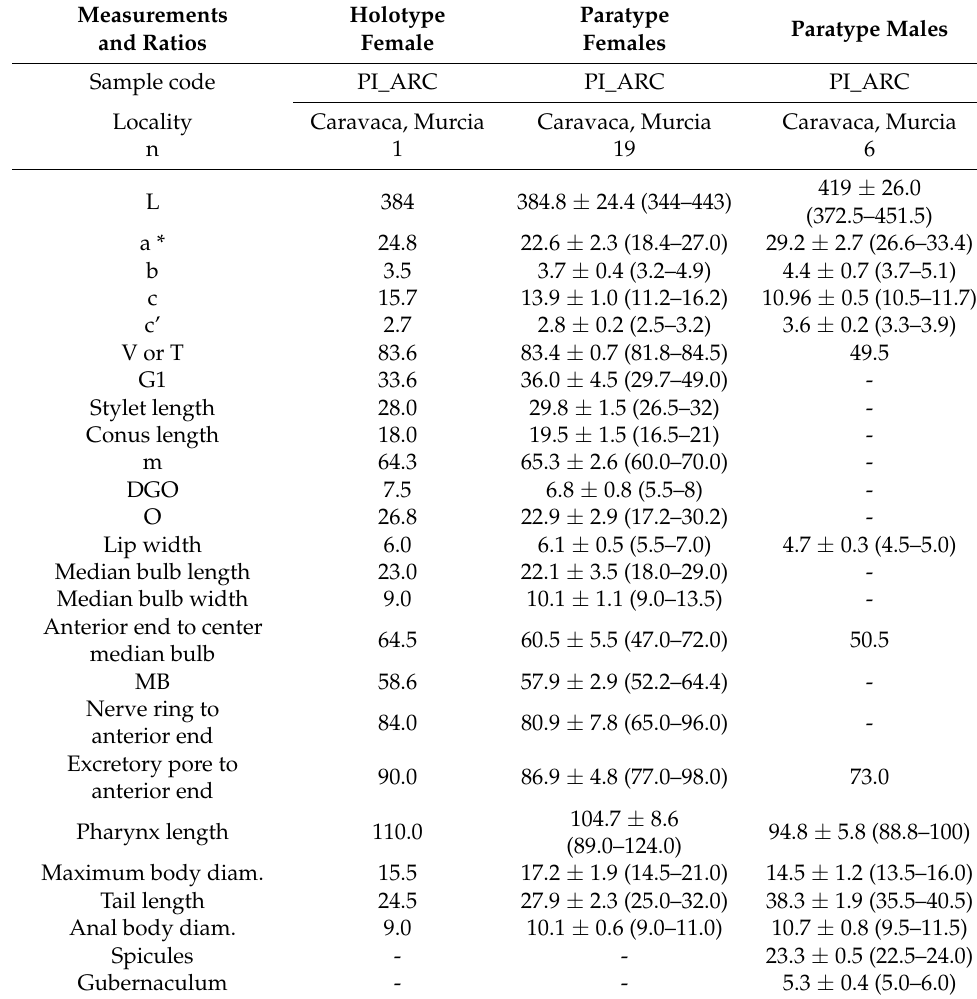
Table 2. Morphometrics of Paratylenchus caravaquenus sp. nov. paratype females and males. All measurements are in µ m and in the form: mean ± s.d.